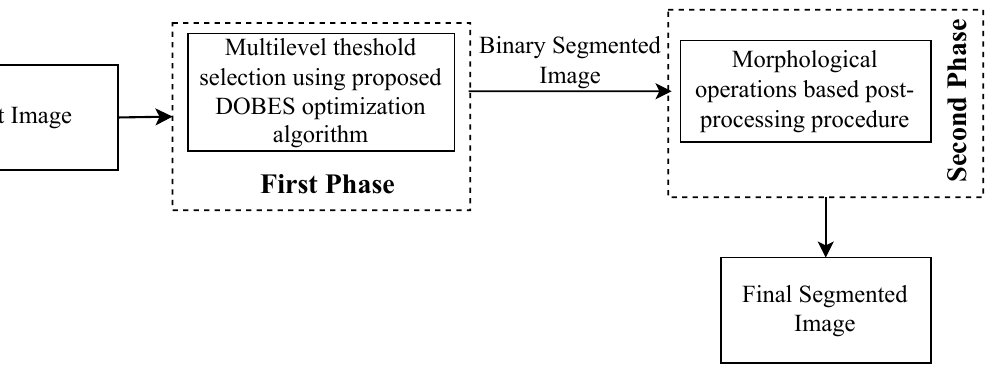
Figure 1. Generalized layout of proposed hybrid segmentation